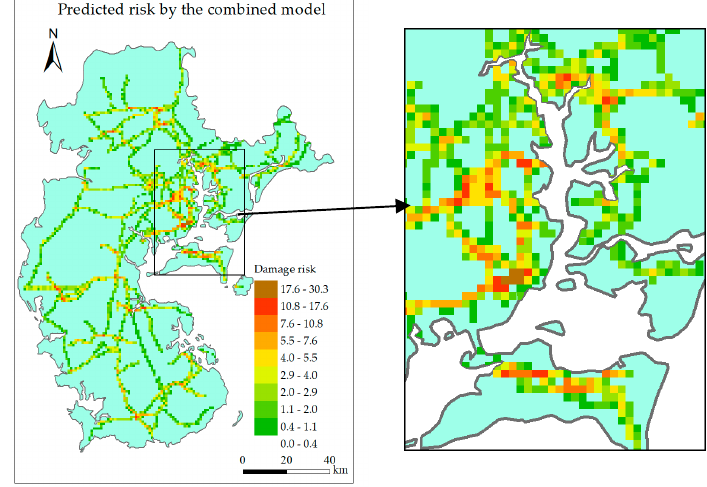
Figure 18. Predicted damage risk of the combined model.